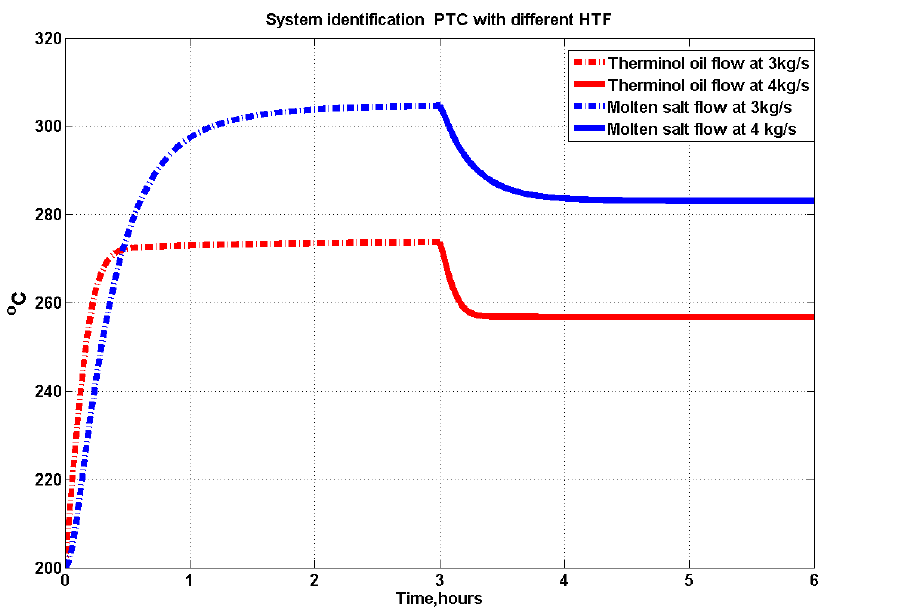
Figure 5. System identification of PTC for therminol oil and molten salt.